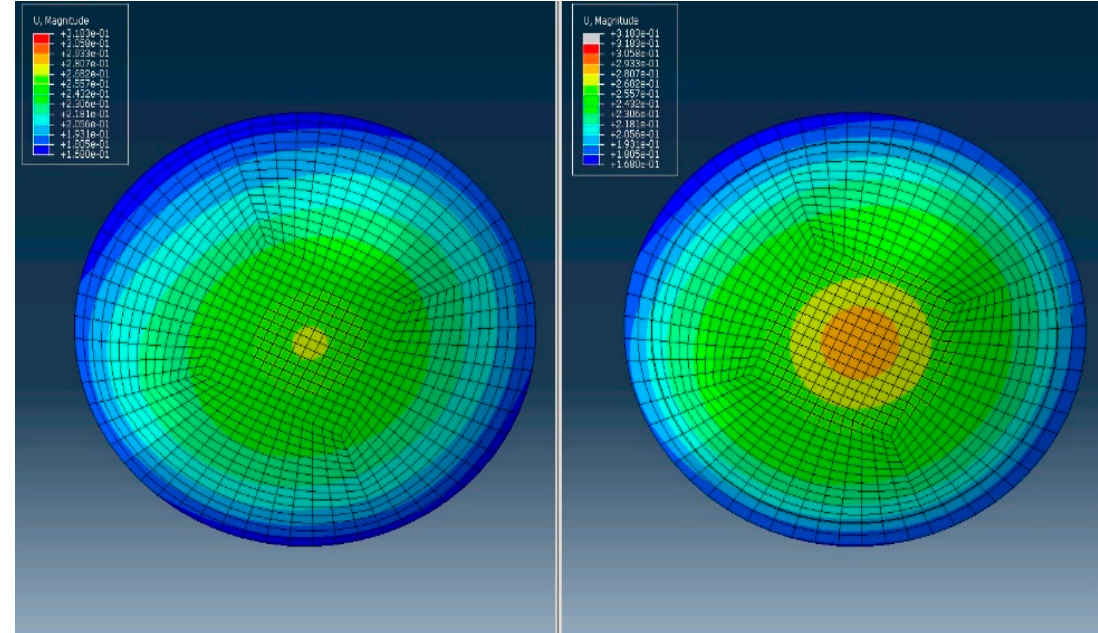
Figure 5. Magnitude of the displacements (mm) in three principal directions (x, y, z) for post-PRK ( left ) and post-LASIK models ( right ) with identical color scales. Residual stromal bed displacements were greater in LASIK than in PRK.